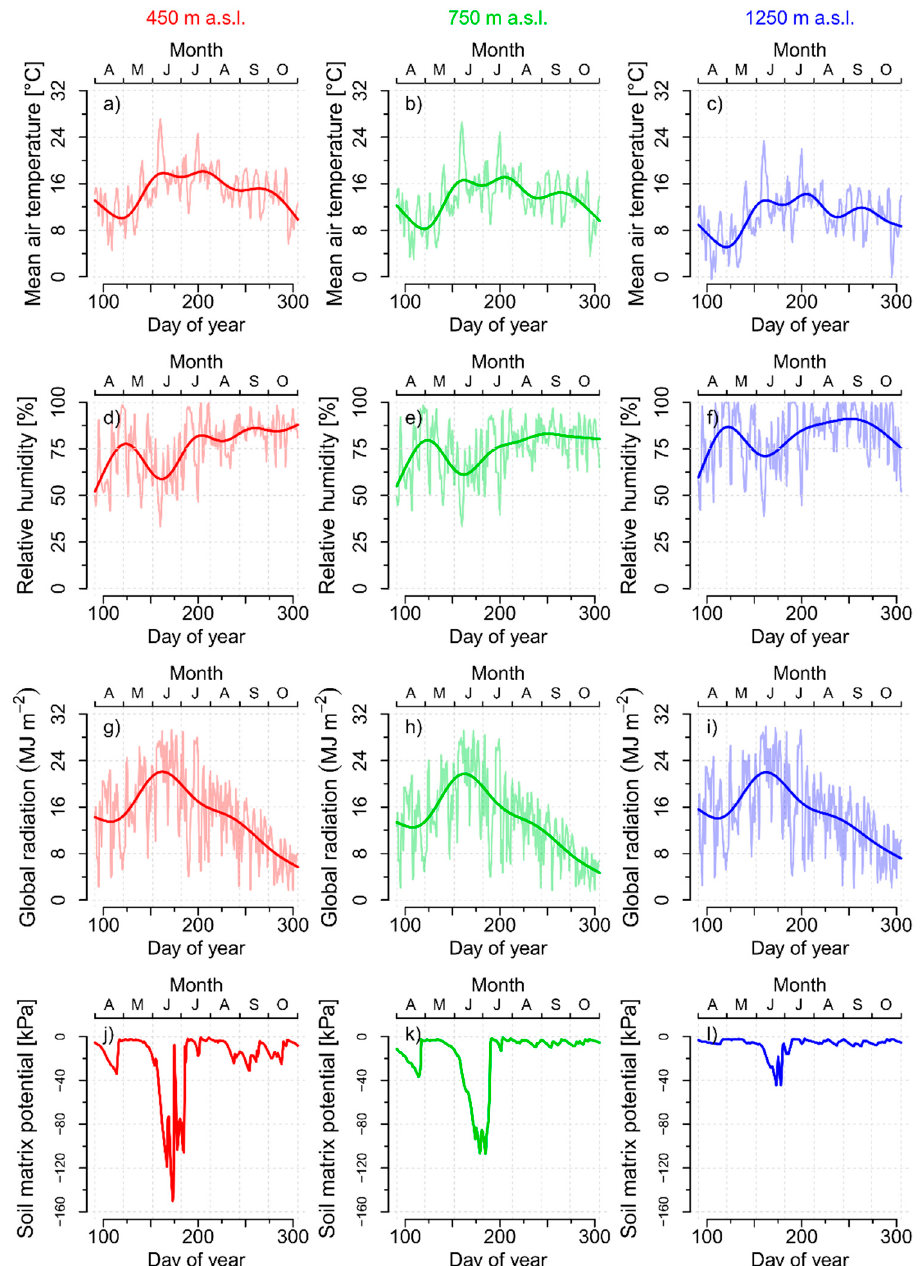
Figure 1. Daily mean values and GAM (generalized additive model) smoothing curves of in situ measurements of air temperature ( a – c ), relative humidity ( d – f ), and of modeled values of the daily sum of global radiation on inclined surfaces ( g – i ). Daily mean values of in situ measurements of soil matrix potential ( j – l ), all for the 450 m ( left ), 750 m ( center ), and 1250 m a.s.l. ( right ) elevation sites, respectively, during the growing season in 2014.